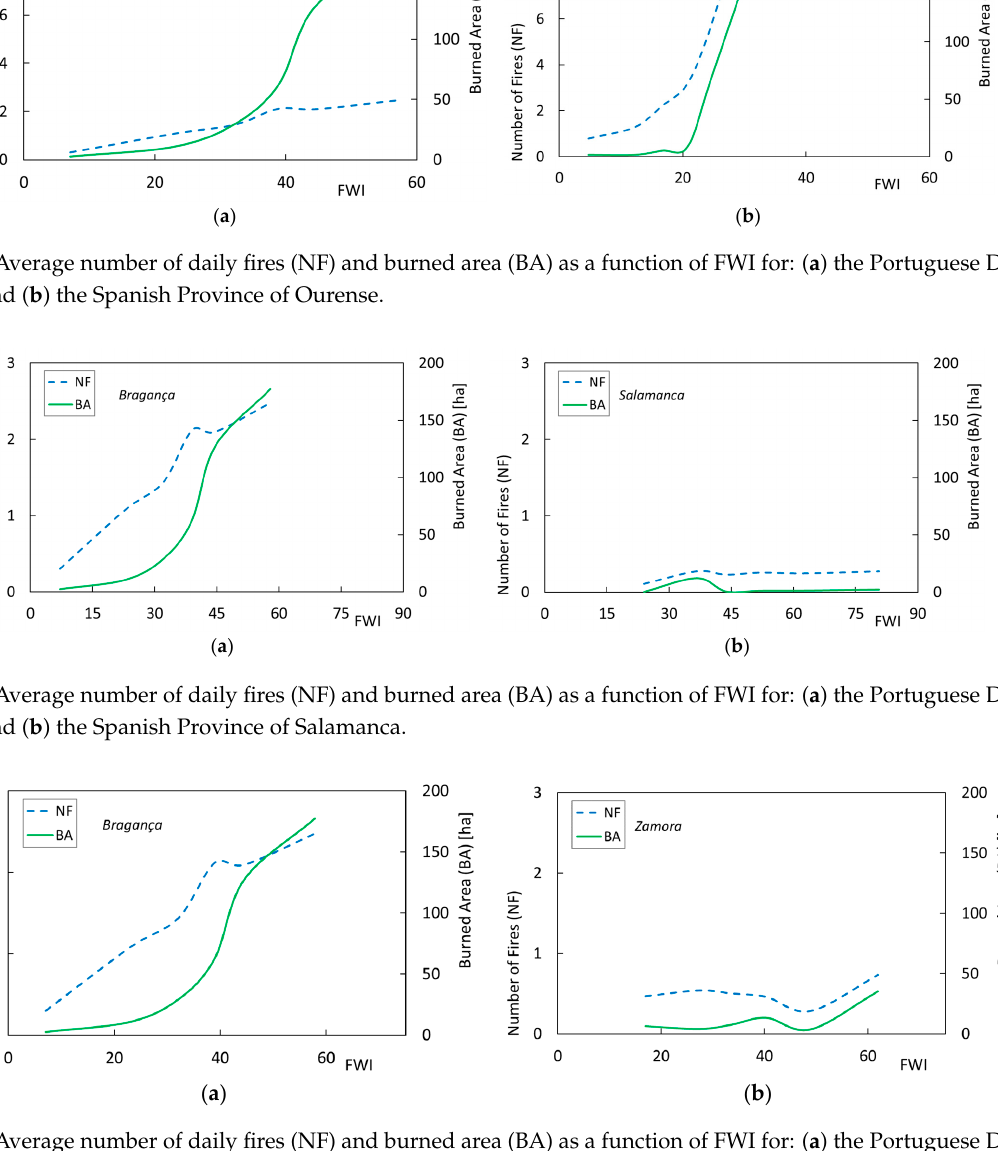
Figure A6. Average number of daily fires (NF) and burned area (BA) as a function of FWI for: ( a ) the Portuguese District of Bragança and ( b ) the Spanish Province of Zamora.